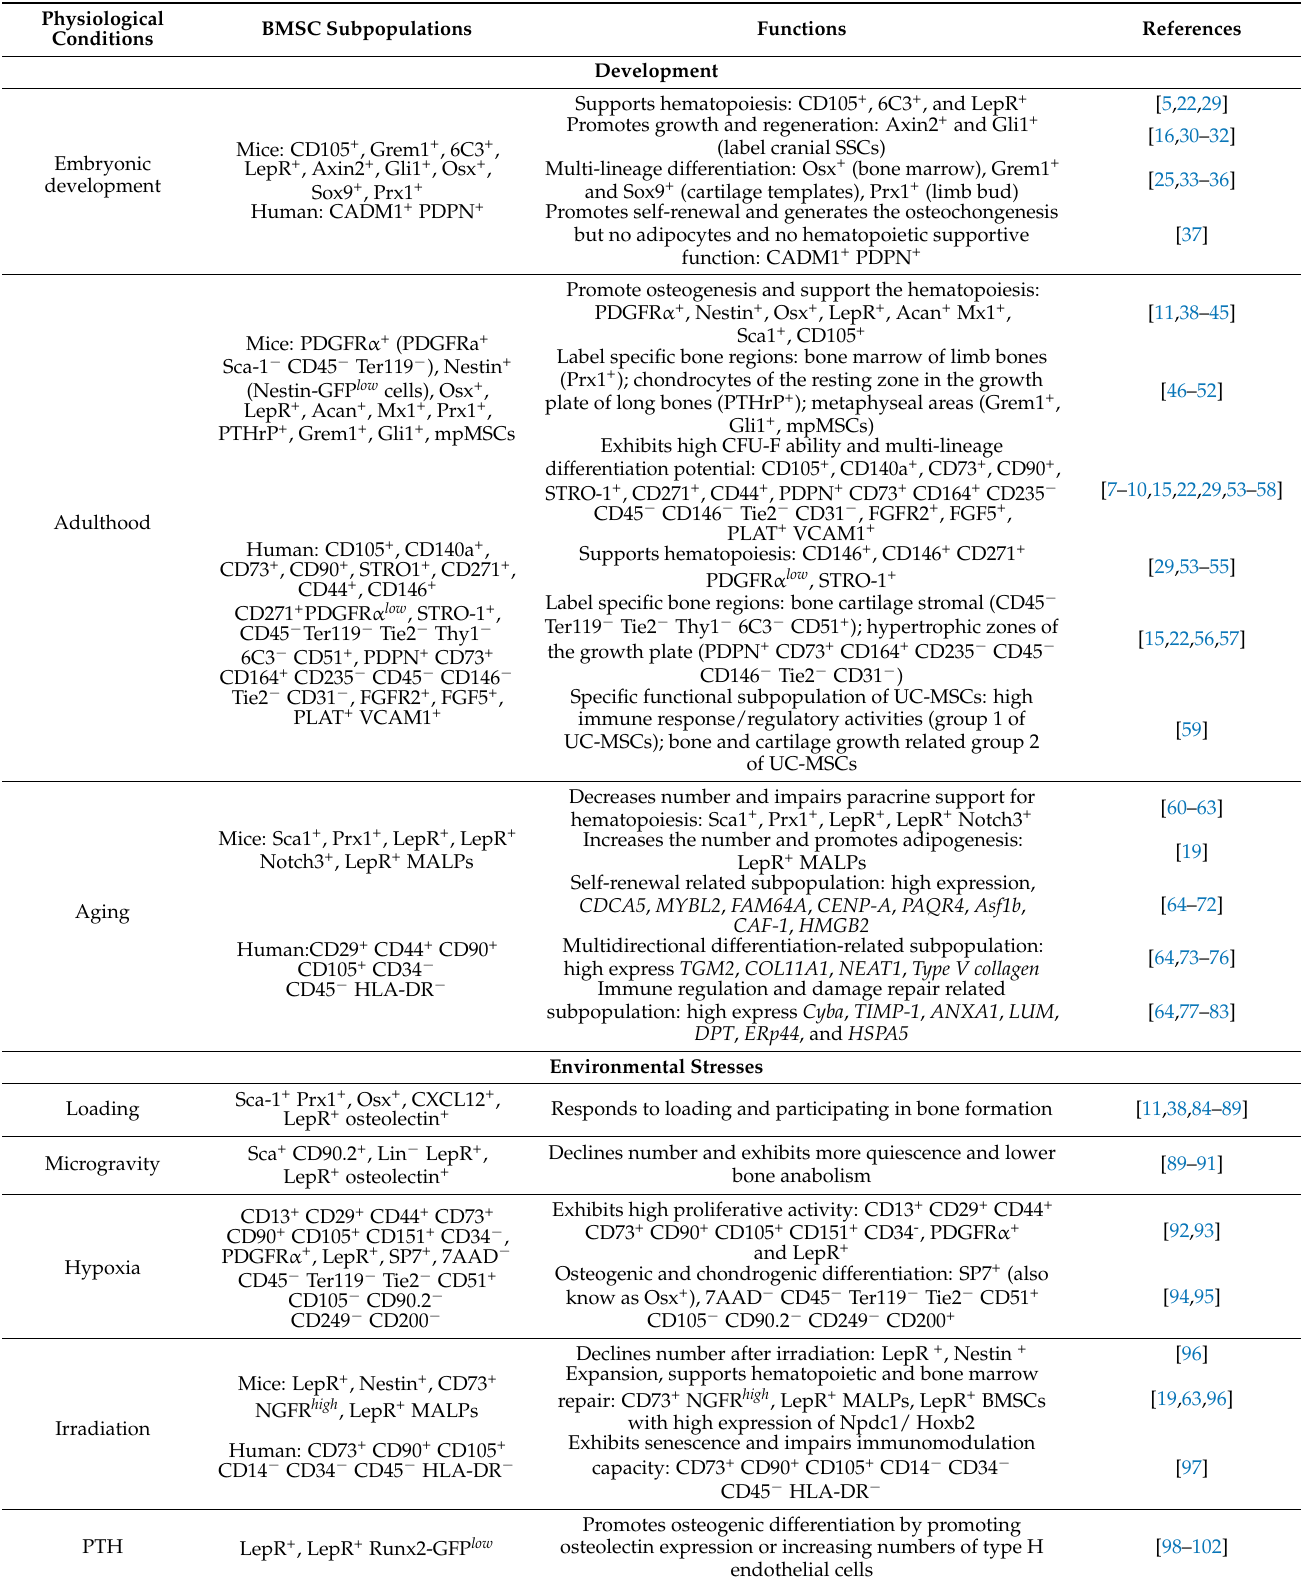
Table 1. Functional heterogeneity of BMSC subpopulations in